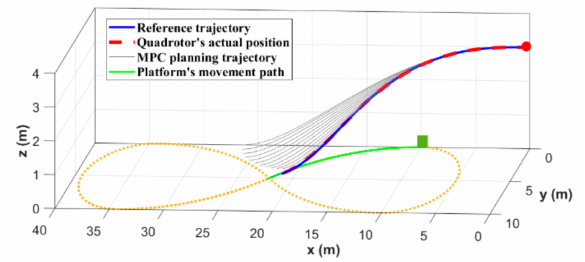
Figure 12. 3D landing trajectory of the quadrotor when the target platform moves along an eight- shaped trajectory.